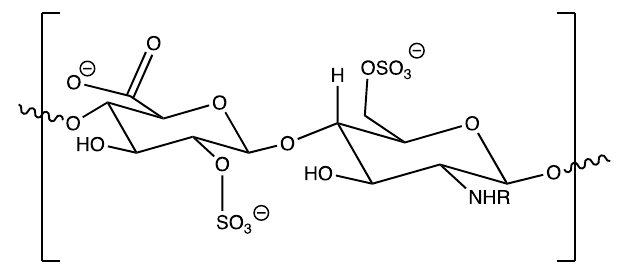
Figure 1. Representative disaccharide units in heparin.